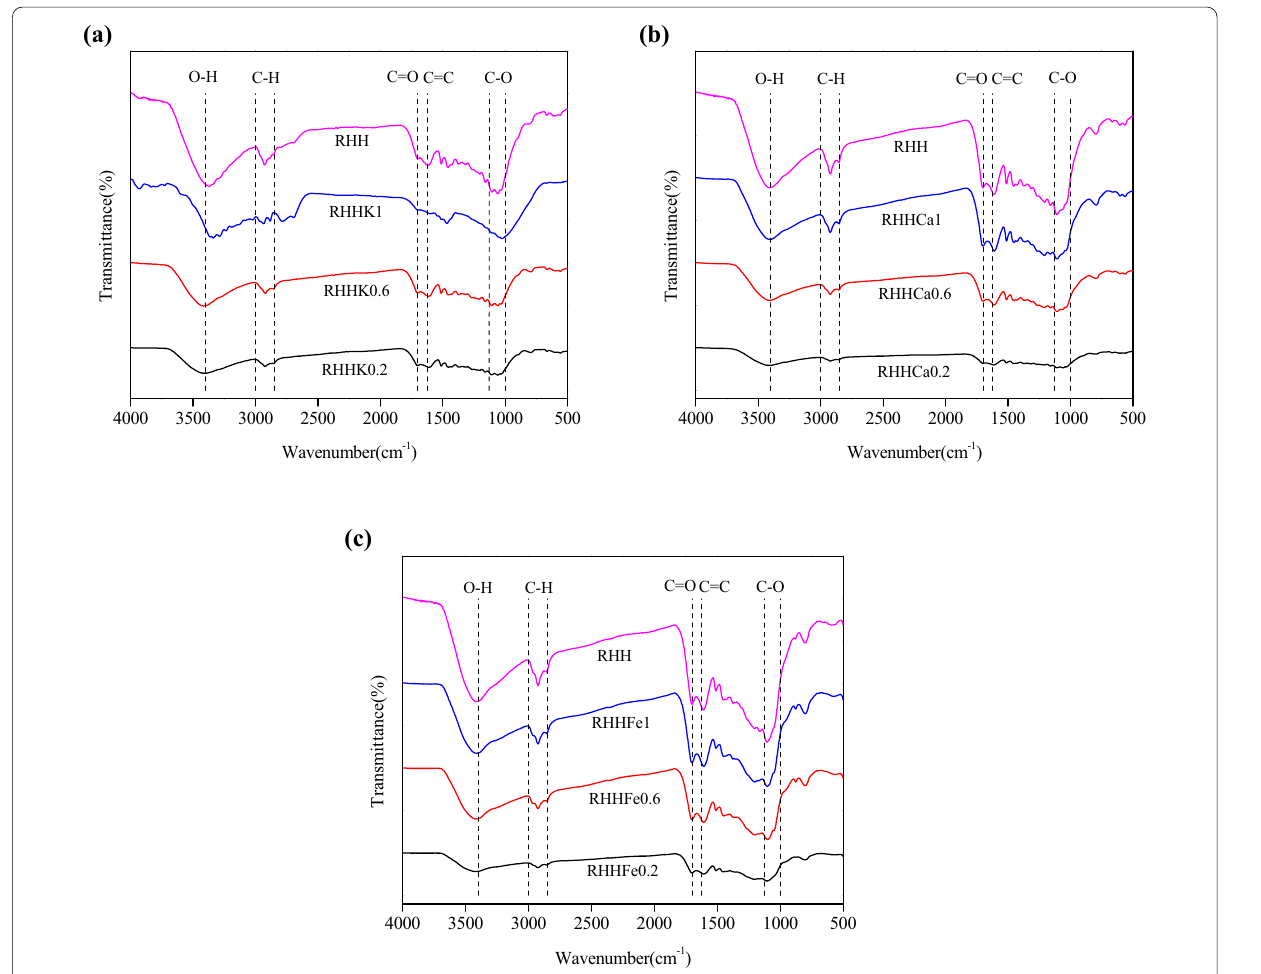
Fig. 2 FTIR spectra of rice husk hydrochar sample a RHH and RHHKs; b RHH and RHHCas; and c RHH and